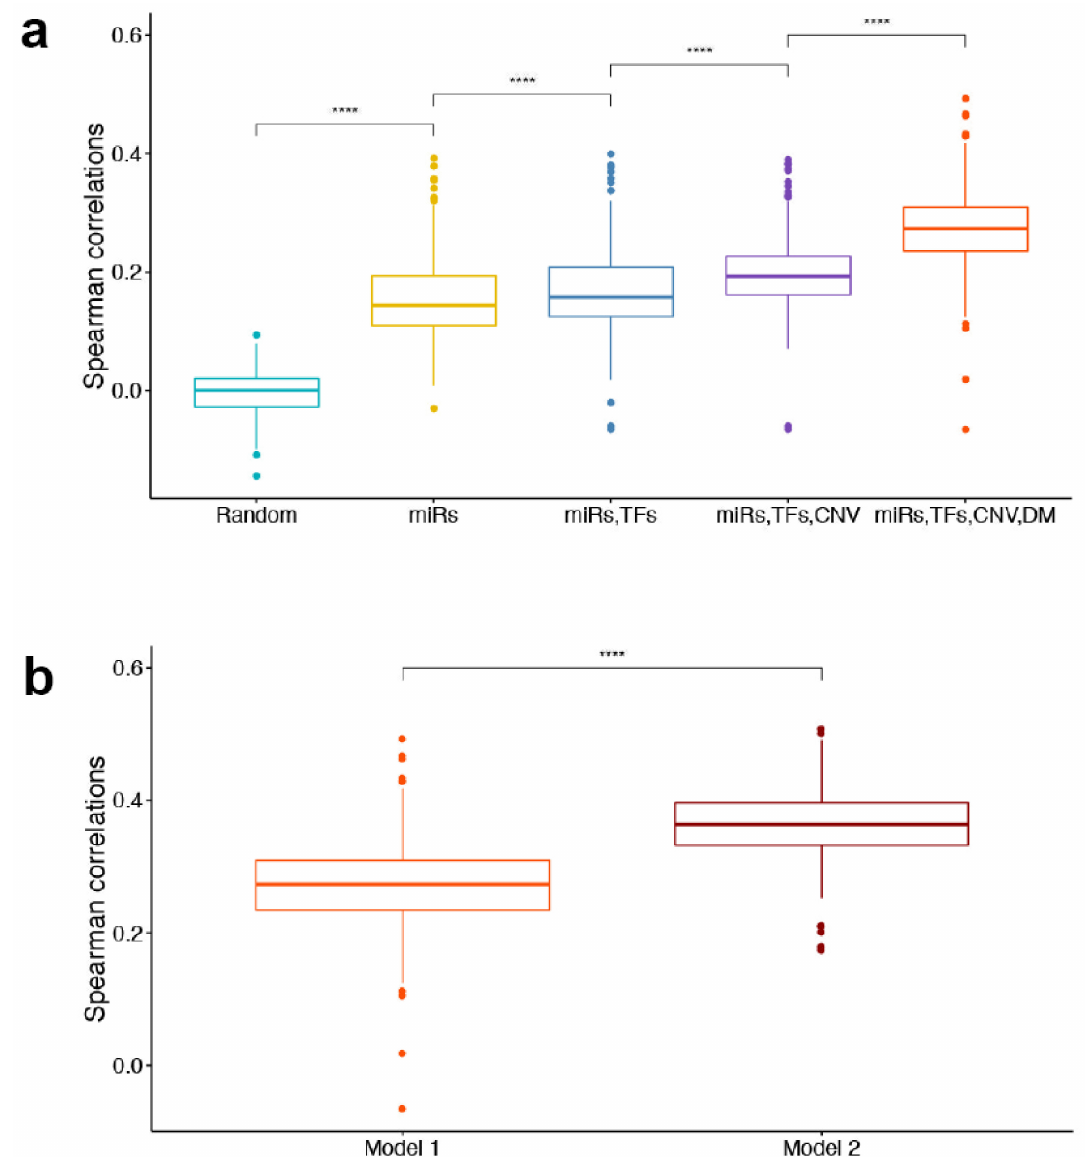
Figure 3. Model comparison. ( a ) The boxplot shows Spearman correlations between predicted and actual gene expression changes for all samples in models with different regulators. Using only miRNA-binding sites as features was significantly better than random; adding TF-binding sites significantly improved CV performance over using only miRNAs-binding sites; adding CNV significantly improved CV performance over using only TF- and miRNA-binding sites, while the model using TF/miRNA-binding sites, CNV and DM outperformed the others. ( b ) Boxplot shows Spearman correlations for all samples in Model 1 and Model 2. Model 1 was trained using CNV, DM, miRNA-binding sites and TF-binding sites from TRRUST, while Model 2 was trained using CNV, DM, miRNA-binding sites and TF-binding sites from ReMap. **** p -value < 2.2 × 10 − 16 by Wilcoxon signed rank